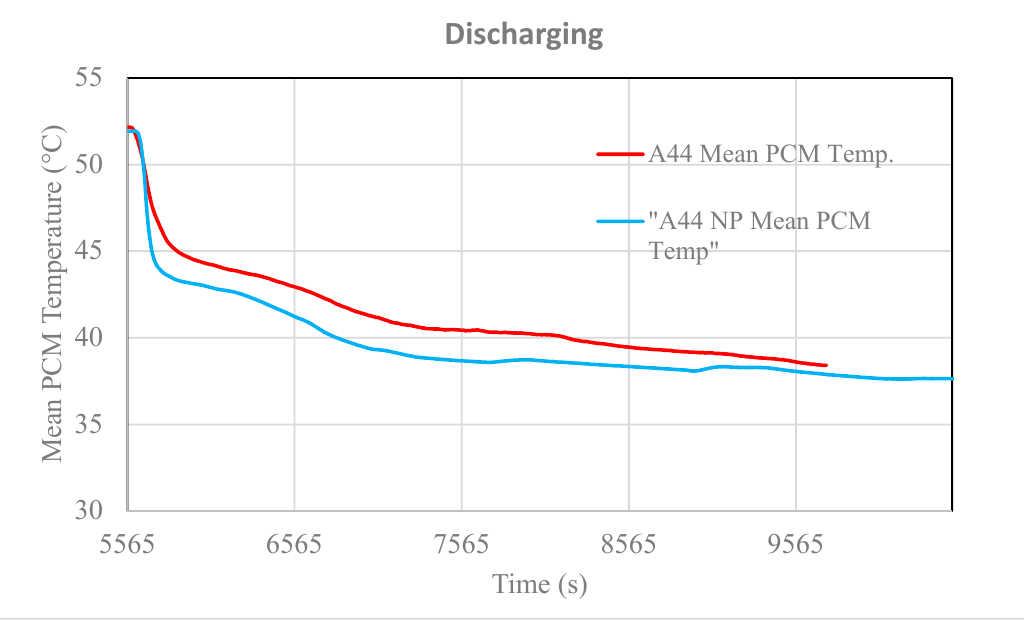
Figure 13. Mean temperature evolution of pure A44 and A44 + NP upon discharging.